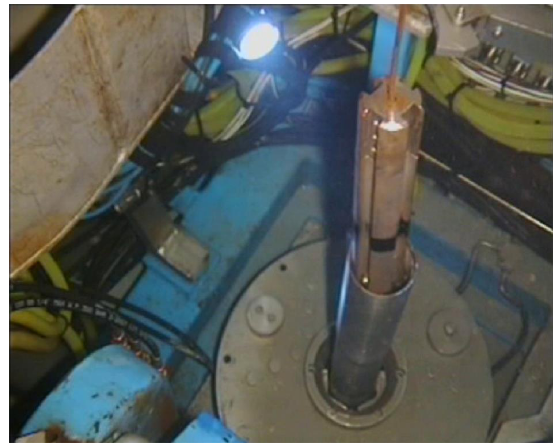
Fig. 5. View of the lower fixed foot clamp of the MeBo. The “over- Figure 5. View of the lower fixed foot clamp of the MeBo. The “overshot” is lowered into the 3 shot” is lowered into the drill string on a steel cable (photo: Marum). drill string on a steel cable (Photo: Marum). 4